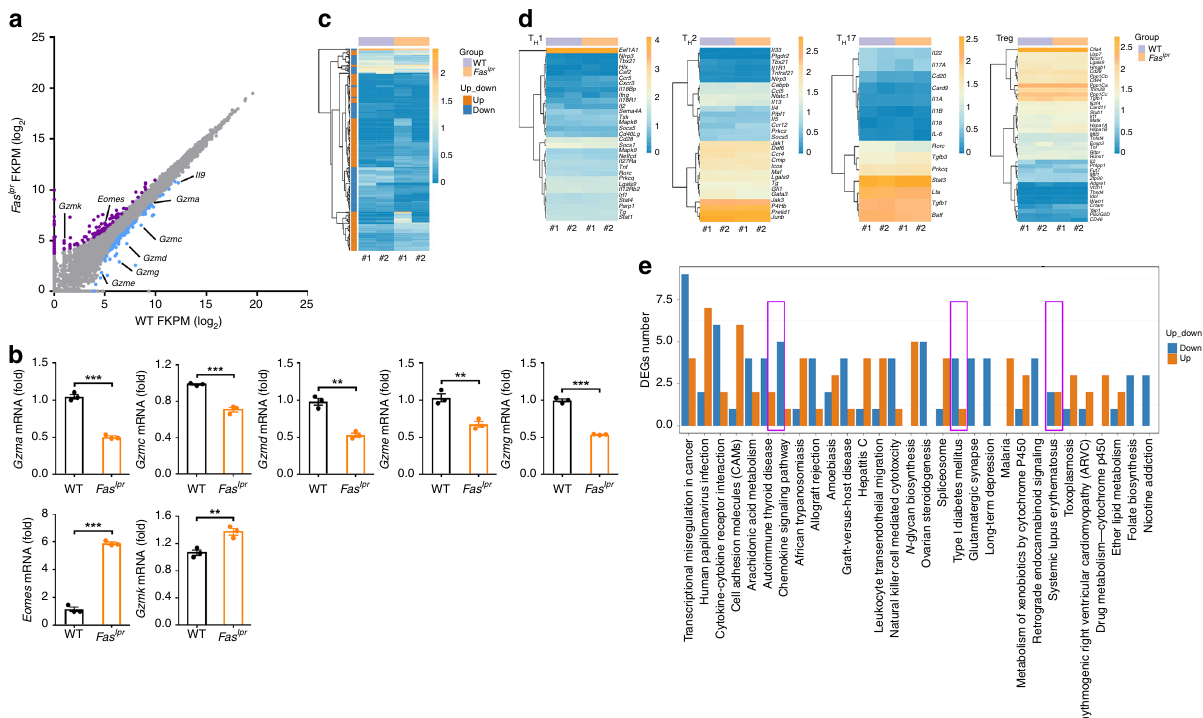
Fig. 2 Fas signaling activates genes related to T helper type 9 (T H 9) cell functions. a Scatterplot of RNA-sequencing data showing genes with expression upregulated (purple dots) or downregulated (blue dots) by at least two-fold in Fas lpr -T H 9 cells relative to wild-type (WT)-T H 9 cells and genes with similar expression in Fas lpr -T H 9 and WT-T H 9 cells (gray dots). b Real-time PCR analysis of the expression of the indicated genes in T H 9 cells differentiated from WT or Fas lpr CD4 + T cells. c Heat map of genes expressed in Fas lpr -T H 9 and WT-T H 9 cells. d Heat map of T H 1 cell-, T H 2 cell-, T H 17 cell-, and Treg-related genes expressed in Fas lpr -T H 9 and WT-T H 9 cell. e Differentially expressed gene (DEG) results for the most highly enriched pathways. Pathways referring to T H 9 cell functions are boxed. FKPM, fragments per kilobase of exon per million fragments mapped. ** P < 0.01 and *** P < 0.001 (unpaired Student ’ s t test). Representative results from three independent experiments are shown (mean and s.d.) ( n =